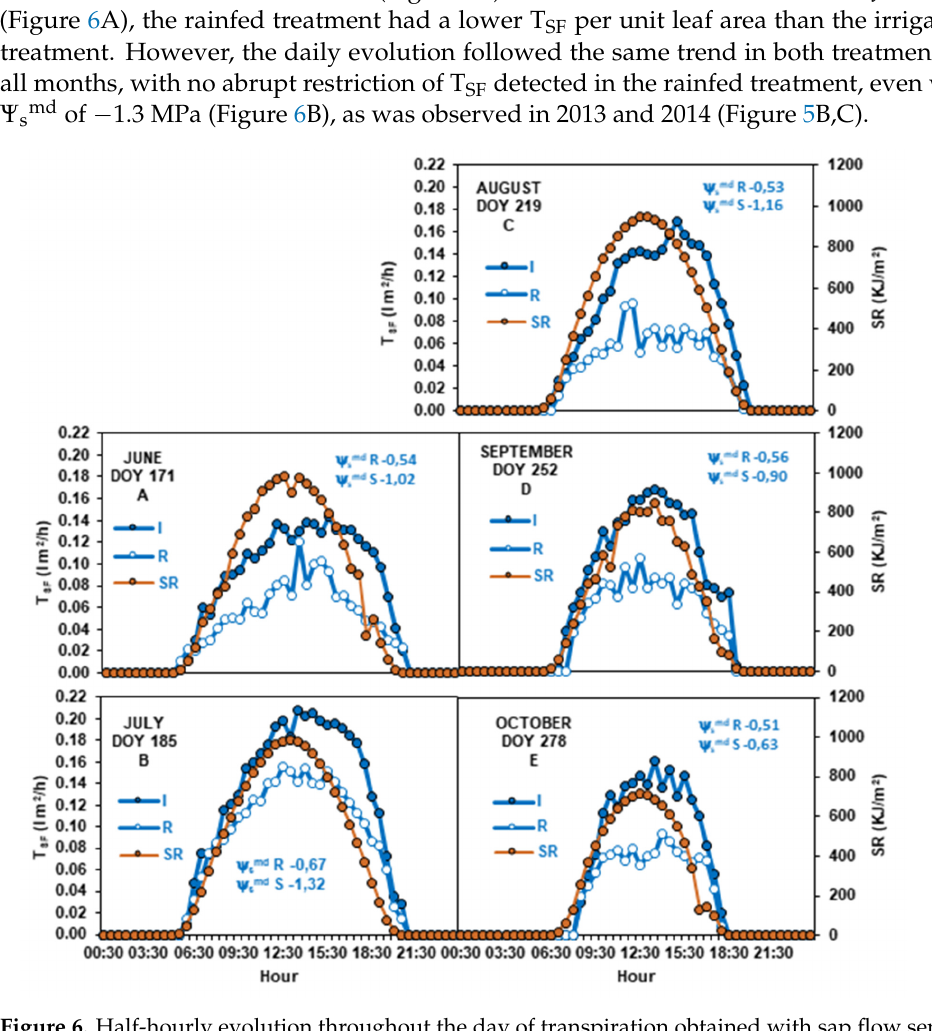
Figure 6. Half-hourly evolution throughout the day of transpiration obtained with sap flow sensors per unit leaf area of the vines (T SF /LA), for the treatments Irrigation (I) and Rainfed (R) and solar radiation (SR) for June (graph ( A )), July (graph ( B )), August (graph ( C )), September (graph ( D )) and October (graph ( E )) of 2012, as well as stem water potential values at midday ( Ψ smd ) in MPa.